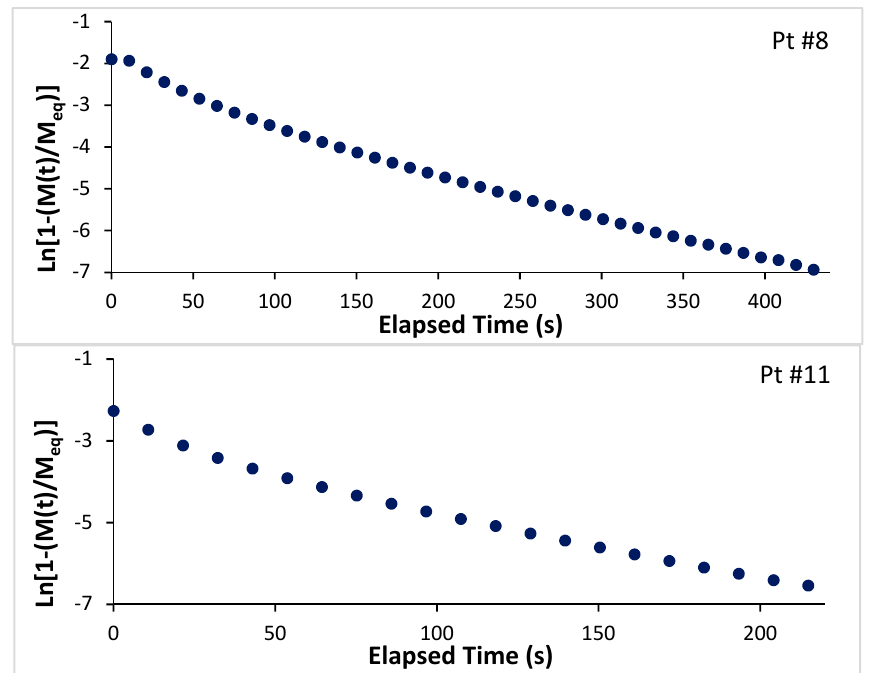
Figure 4. Mass loading as a function of time elapsed using an expression derived from Equation (1) for two points along the 82.07 K isotherm (top panel for point 8 along the isotherm; bottom panel for point 11 along the isotherm). If the linear driving force model were to describe the data accurately, the plots should be straight lines. With the exception of the initial times, the linear driving force model does an adequate job of describing the data.